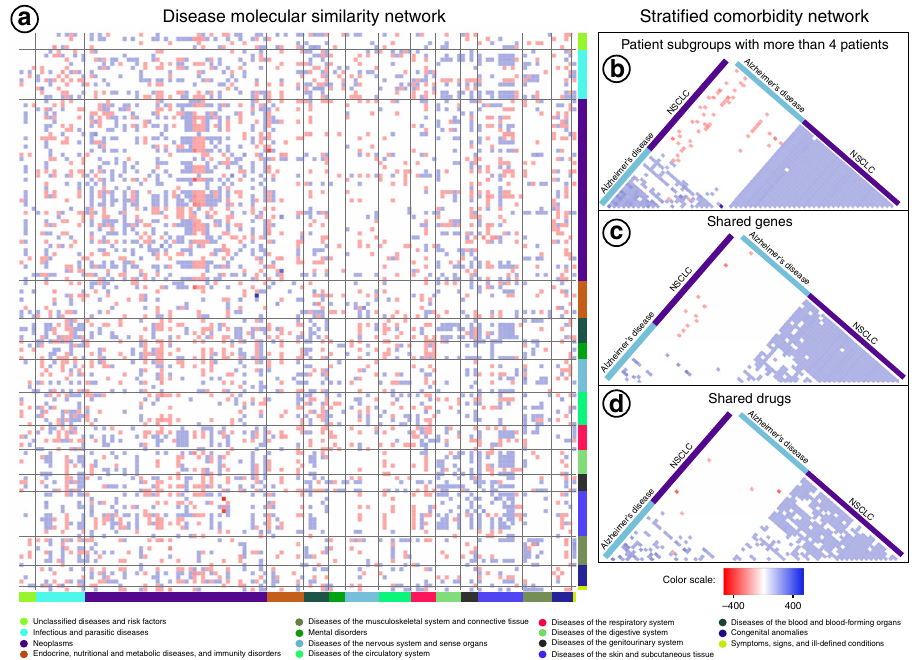
Fig. 3 Heatmap representation of the Disease Molecular Similarity Network and the Strati fi ed Comorbidity Network. Blue and red squares represent positive and negative Relative Molecular Similarities (pRMS and nRMS) respectively. a Heatmap representation of the Disease Molecular Similarity Network (DMSN). Intensity of the interactions denotes the relative molecular similarity values, interpreted as relative risk interactions, which go from rows to columns. Diseases are colored based on the disease category they belong to (International Code of Diseases, ICD-9-CM). b Heatmap of the interactions between NSCLC and Alzheimer ’ s disease patient-subgroups with at least four patients. c Heatmap of the interactions between NSCLC and Alzheimer ’ s disease patient-subgroups with at least four patients and at least one gene differentially expressed in the same direction in all the patients within the same subgroup. Blue and red squares represent respectively pRMS and nRMS with shared genes in the correct direction (at least one gene differentially expressed in the same direction in all the patients within the two subgroups in the case of positive interactions, and in opposite directions in the case of negative interactions). d The same as ( c ) but with drugs instead of genes.